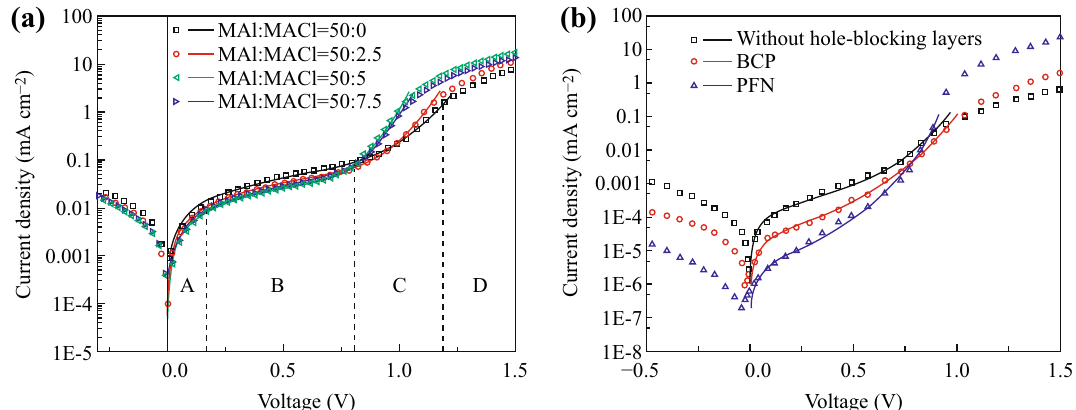
Fig. 4 Plots of dark current of planar PSCs as well as fitting curve by using Eq. 13. a The device structure is shown in Fig. 1c, the perovskite films prepared by mixing with different concentrations of Cl ions. b The device structure is PEDOT:PSS/CH 3 NH 3 PbI 3-x Cl x /PCBM/hole-blocking layer/Al, with the original data coming from the Ref. [8]. The inset regions A, B, C, D are mainly determined by shunt current, recombination current in diode space-charge region, diffusion current, diode diffusion current limited by series resistance, respectively. (Color figure